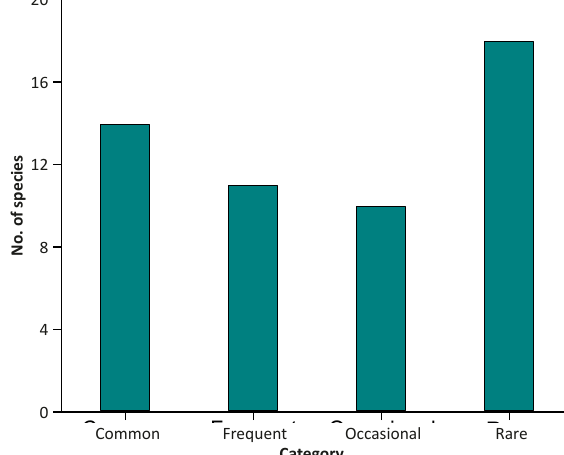
Figure 2. Categories of relative occurrence of species recorded in